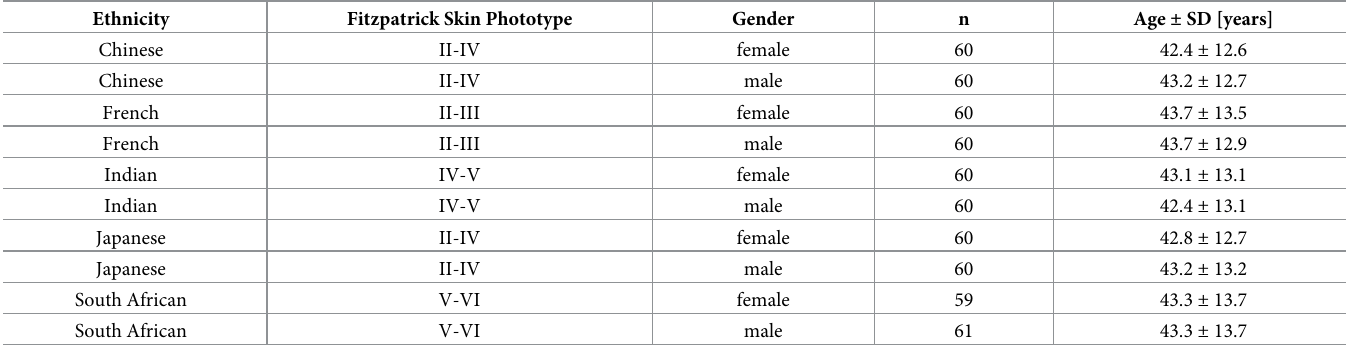
Table 2. Sociodemographic information and skin pigmentation of assessors in the rating study.